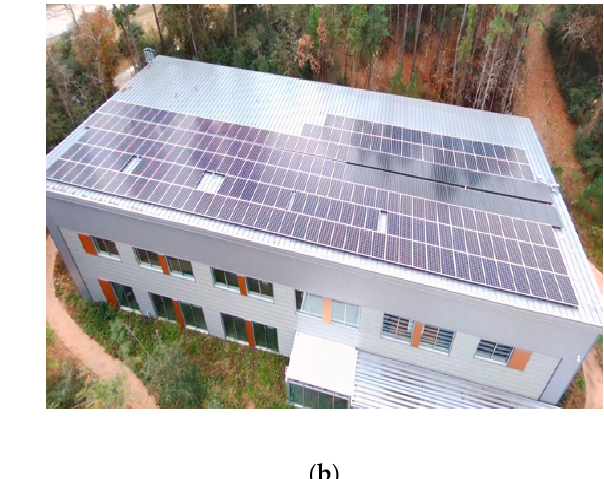
Figure 3. Data analysis steps . The data analyzed in this paper consisted of 1-year data collected from four meters that capture 1 min consumption of an HVAC system, lighting, plug loads, and others. Table 1 describes the raw data and wrangled data used in the analysis.